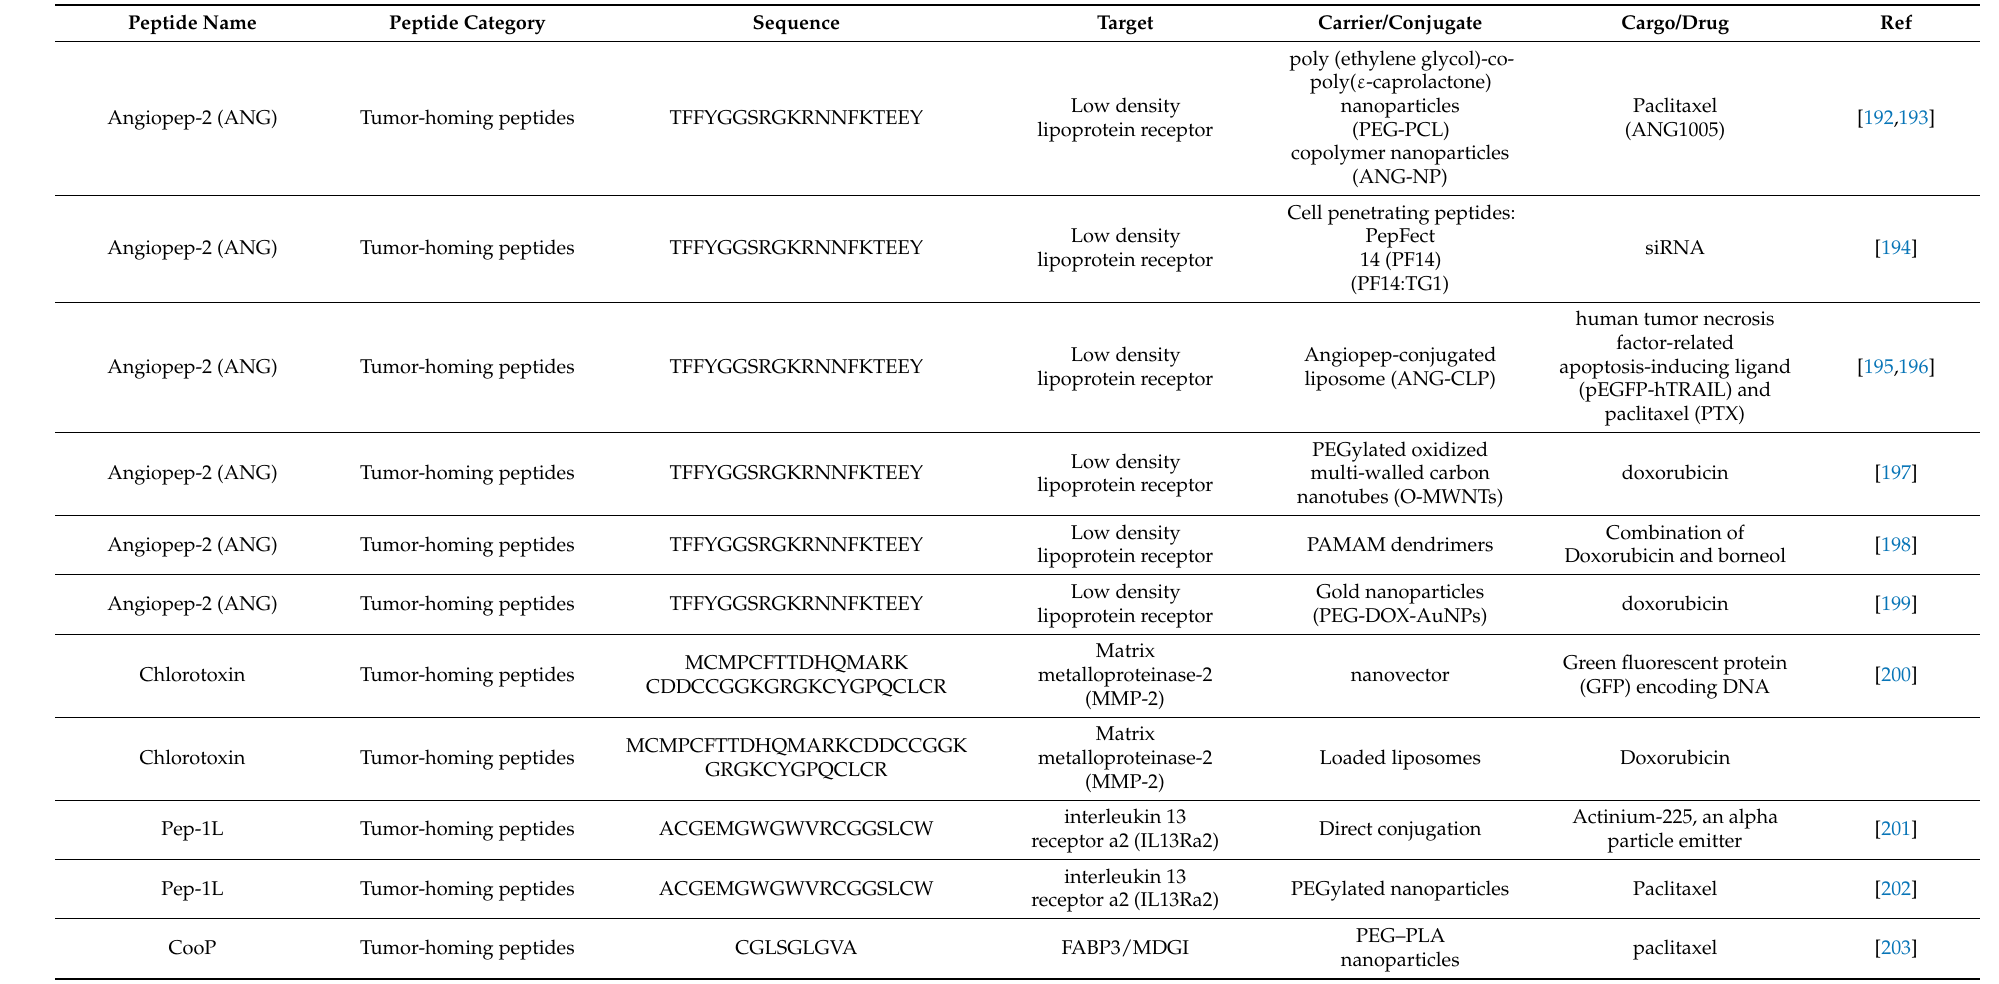
Table 2. Peptide-based treatment in